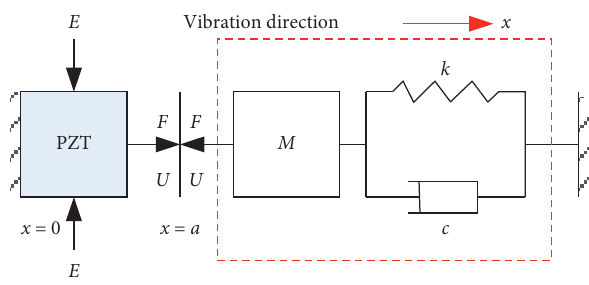
Figure 4: EMI measurement principle.